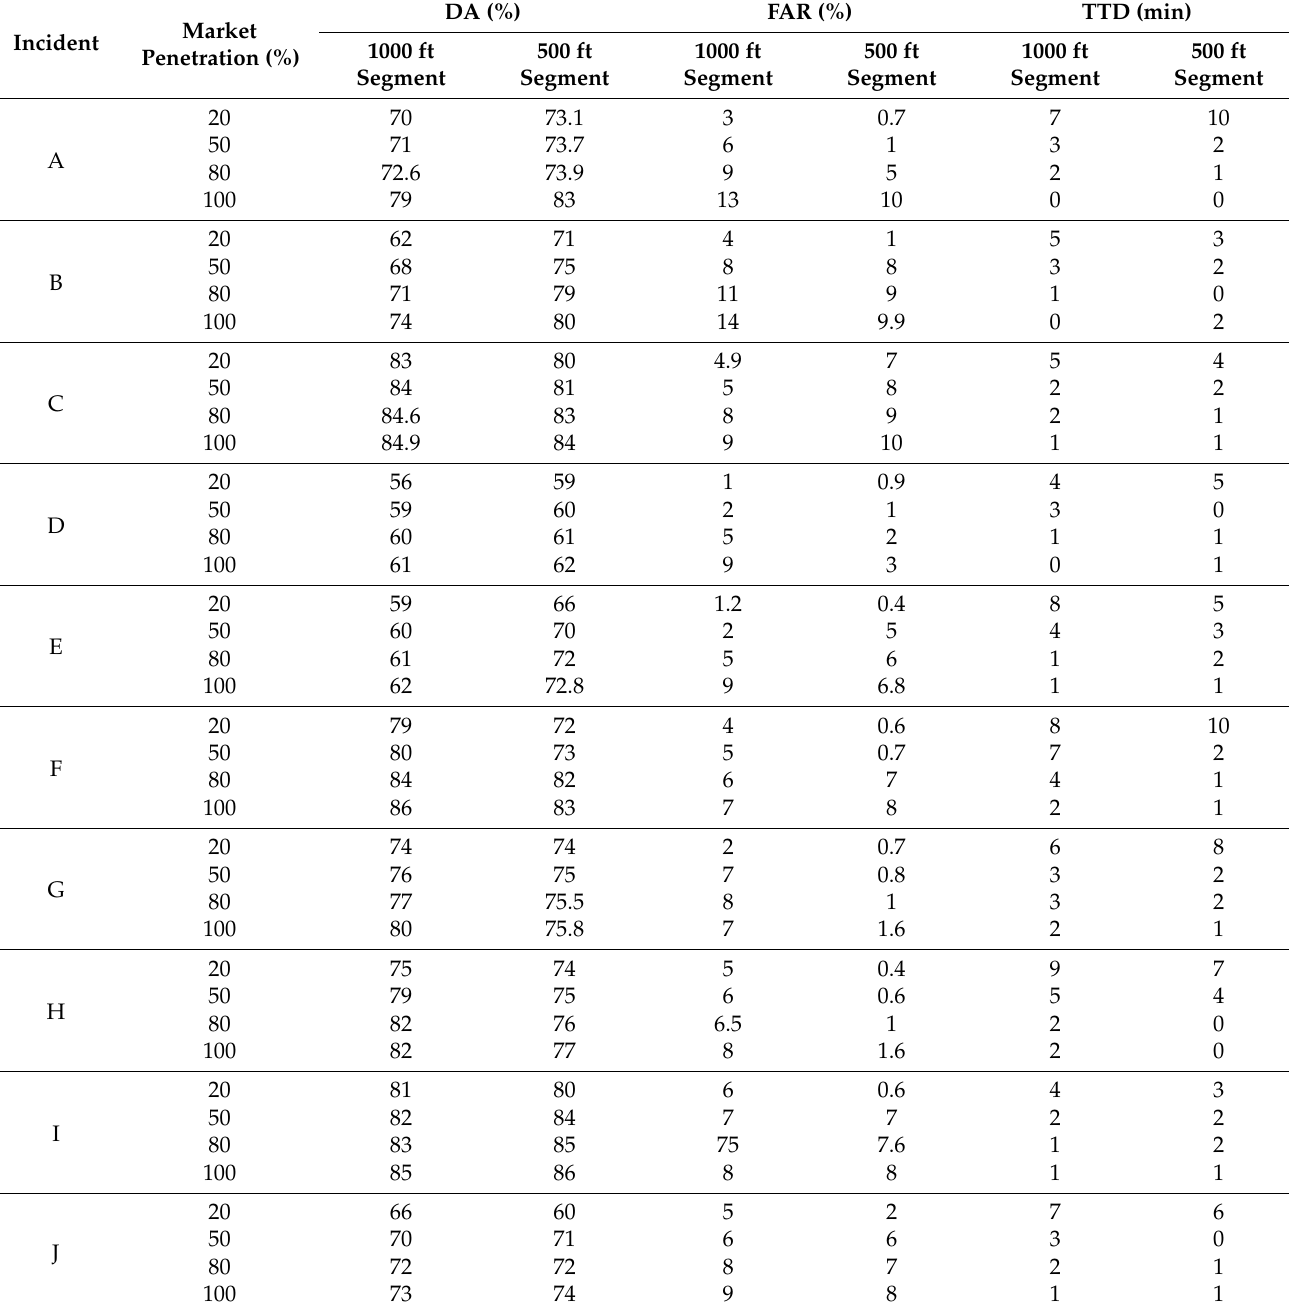
Table 2. Sensitivity analysis of the performance of V2I-based